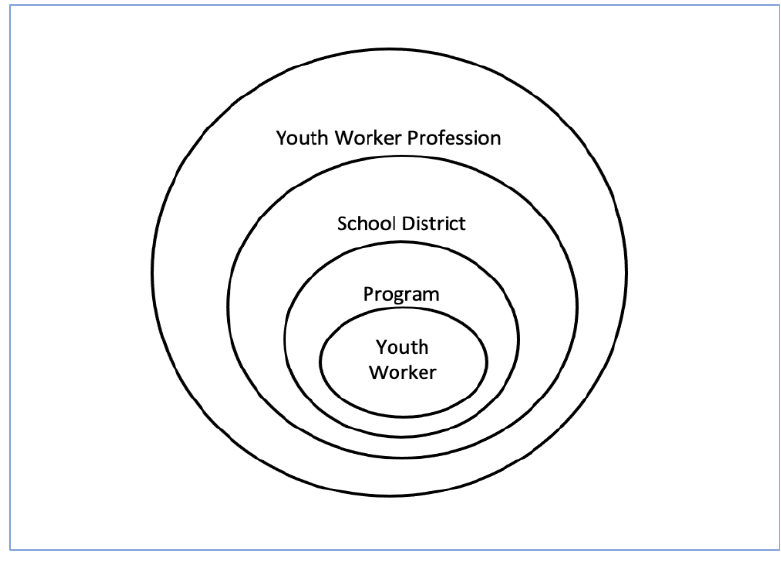
Figure 2. Conceptualizing Youth Worker Learning as Part of a Broader Ecology